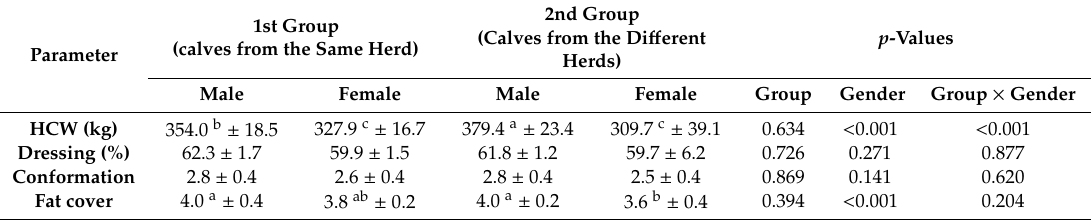
Table 2. Carcass quality traits evaluation for investigated groups of Simmental cattle. 2nd Group 1st Group (Calves from the Di ff (calves from the Same Herd) Parameter